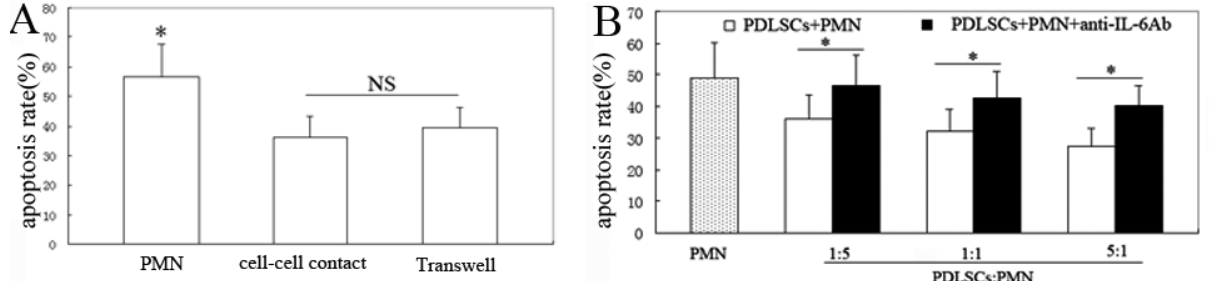
Figure 2: IL-6 is the critical factor in the PDLSCs-mediated reduction of PMN apoptosis. (A) PMN apoptosis was equally suppressed by PDLSCs in both cell-cell contact culture and Transwell culture. (B) The apoptosis of PMN increased markedly when anti-IL-6 neutralizing antibody was added into the co-culture of PDLSCs and PMN. *: P < 0.05 vs other groups. NS: not significant. Data are expressed as mean ± SD of triplicates from six independent